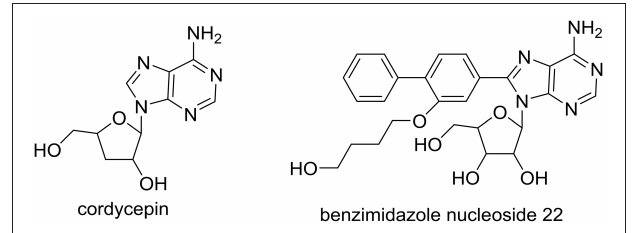
FIGURE 1 | Structure of cordycepin in C. militaris and benzimidazole nucleoside 22 for